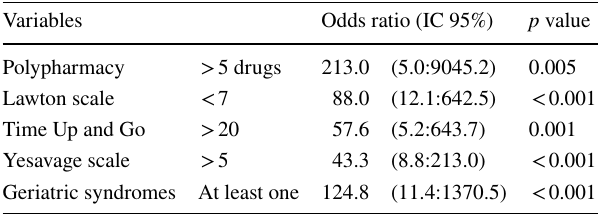
Table 4 Multivariate model of frailty adjusted by age and using 5